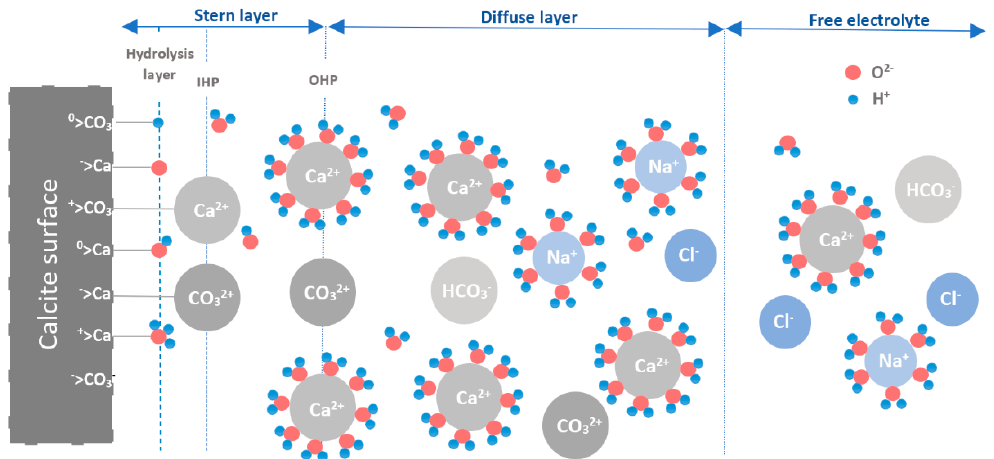
Figure 1. Illustration of the electrical double layer of calcite surface in water with NaCl as the electrolyte. IHP and OHP stand for the inner and outer Helmholtz planes, respectively [22]. Table 5. IEP calcite values and their measurement operating conditions.